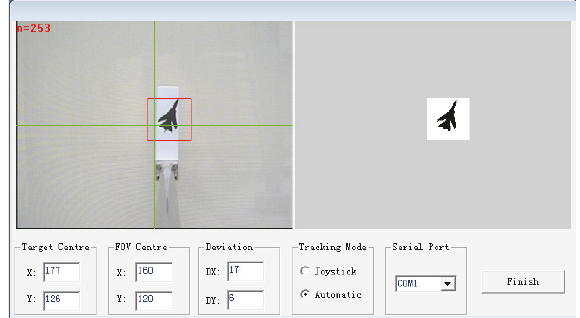
Figure 13: TV guidance image processing interface.